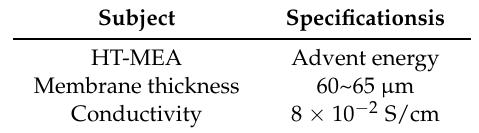
Table 2. Specifications of the HT-MEA.